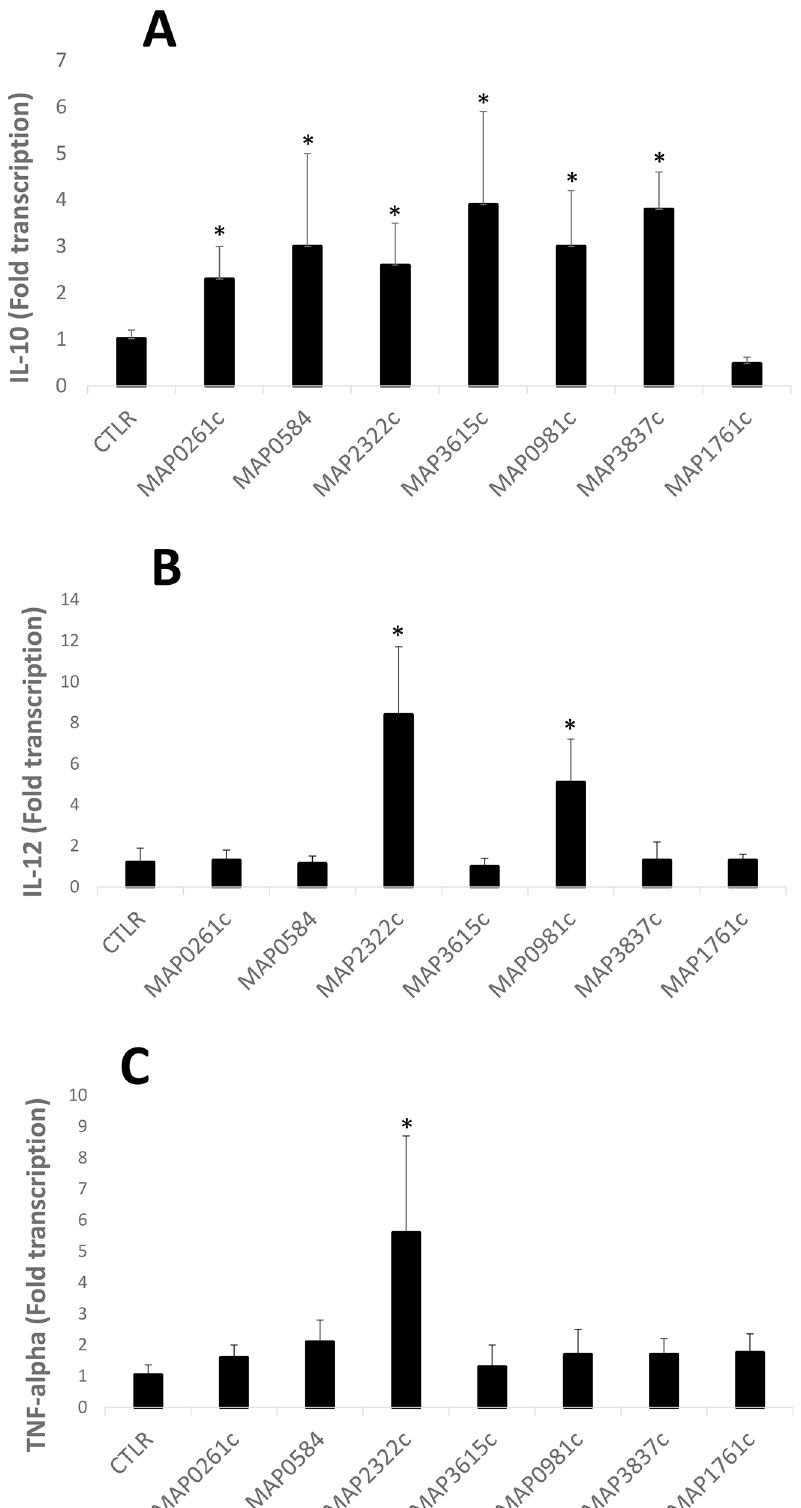
Fig 1. Cytokine expression levels of bovine macrophages in response to MAP recombinant proteins. Shown are IL-10 (A), IL-12 (B) and TNF- α (C), mRNA transcription levels in response to 2-h incubation with